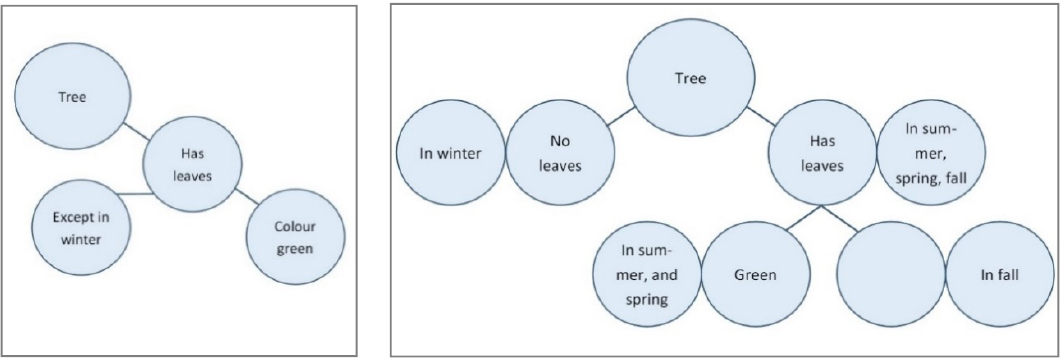
Figure 8. Saliency of missing information in both structures.